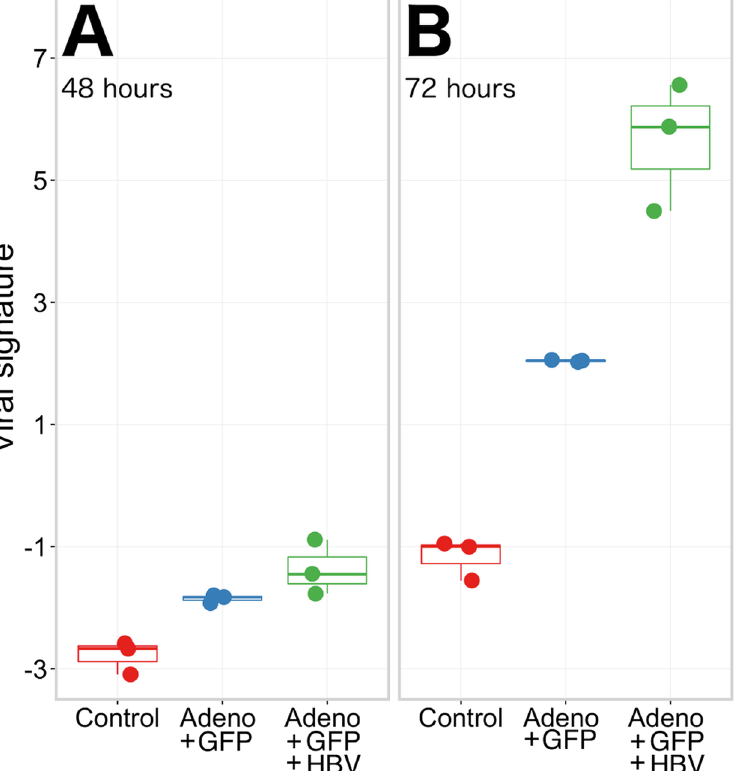
Figure 6. Pan-viral signature scores in primary rat hepatocytes infected with an adenovirus vector containing GFP, or GFP plus Hepatitis B virus. Box-and-whisker plots for the pan-viral signature score over time course of infection in primary rat hepatocytes (GEO dataset GSE68112). Primary rat hepatocytes were plated at 0 hours, and then infected with an adenovirus vector (Control), the adenovirus vector fused to a gene for Green Fluorescent Protein (Adeno + GFP), or the adenovirus vector fused to both the Green Fluorescent Protein gene and a copy of the Hepatitis B Virus genome (Adeno + GFP + HBV). Panel (A): response after 48 hours. Panel (B): response after 72